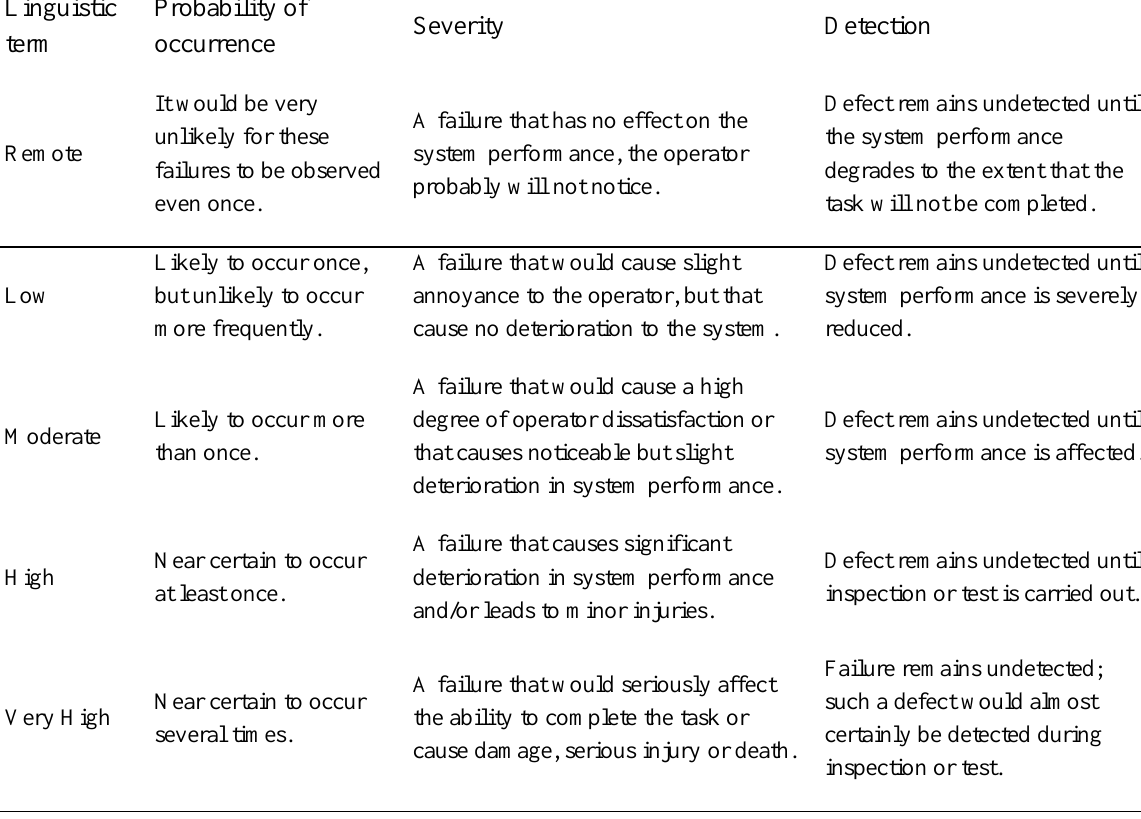
Table 1. Interpretations of Linguistic Terms for Developing the Fuzzy Rule Based System [3].